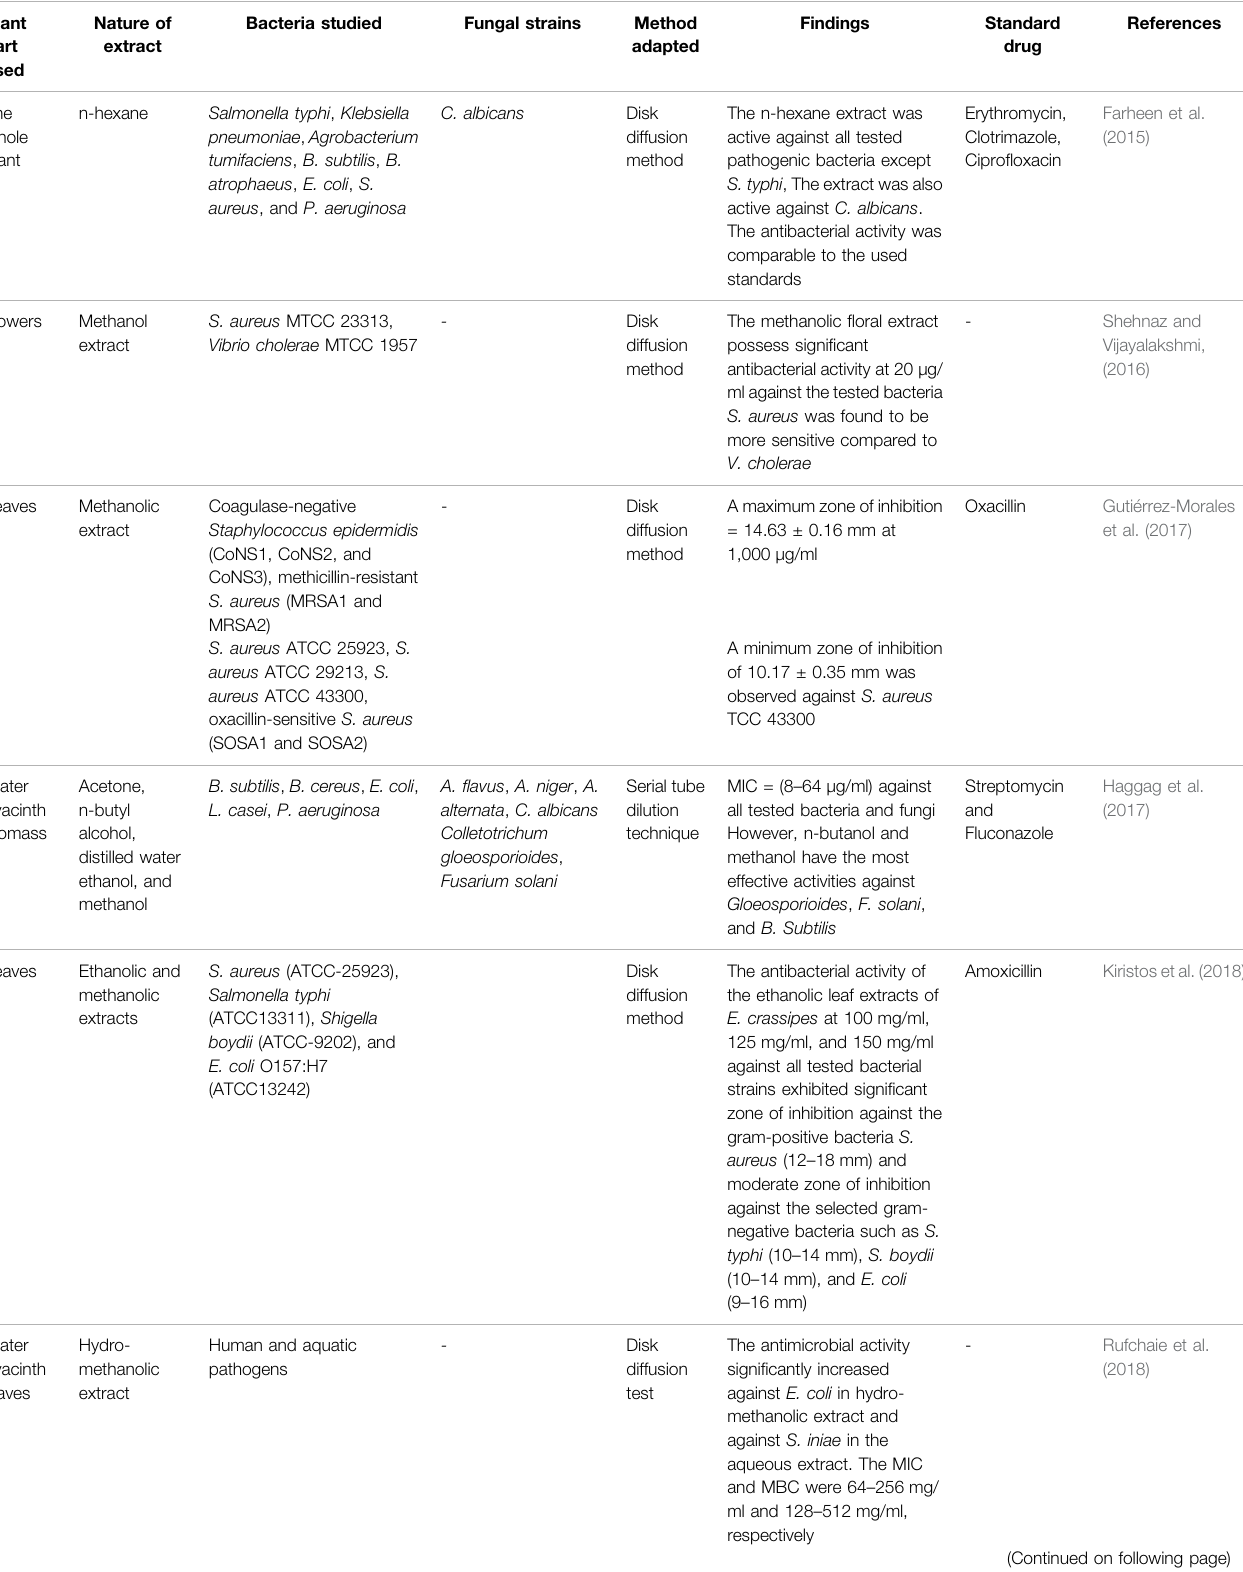
TABLE 4 | Bactericidal and antifungal potential of various extracts of E. crassipes. Plant